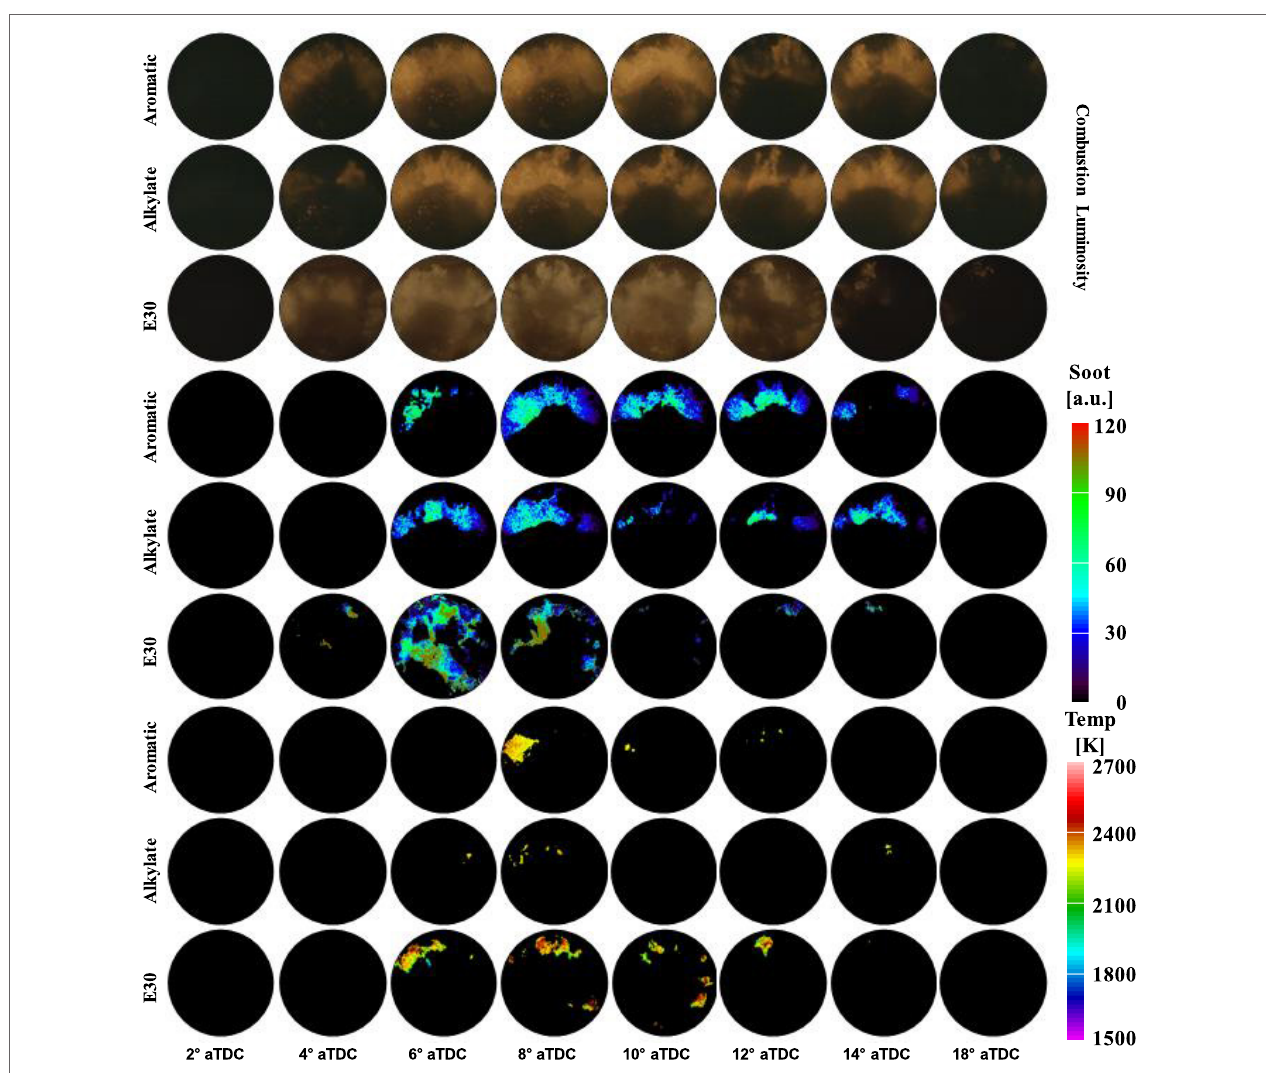
FigUre 8 | Endoscope images (original, soot, and temp) of three fuels (aromatic, alkylate, and E30) at exhaust gas recirculating = 25%, λ = 1.8 over selected crank angles for complete combustion/emission